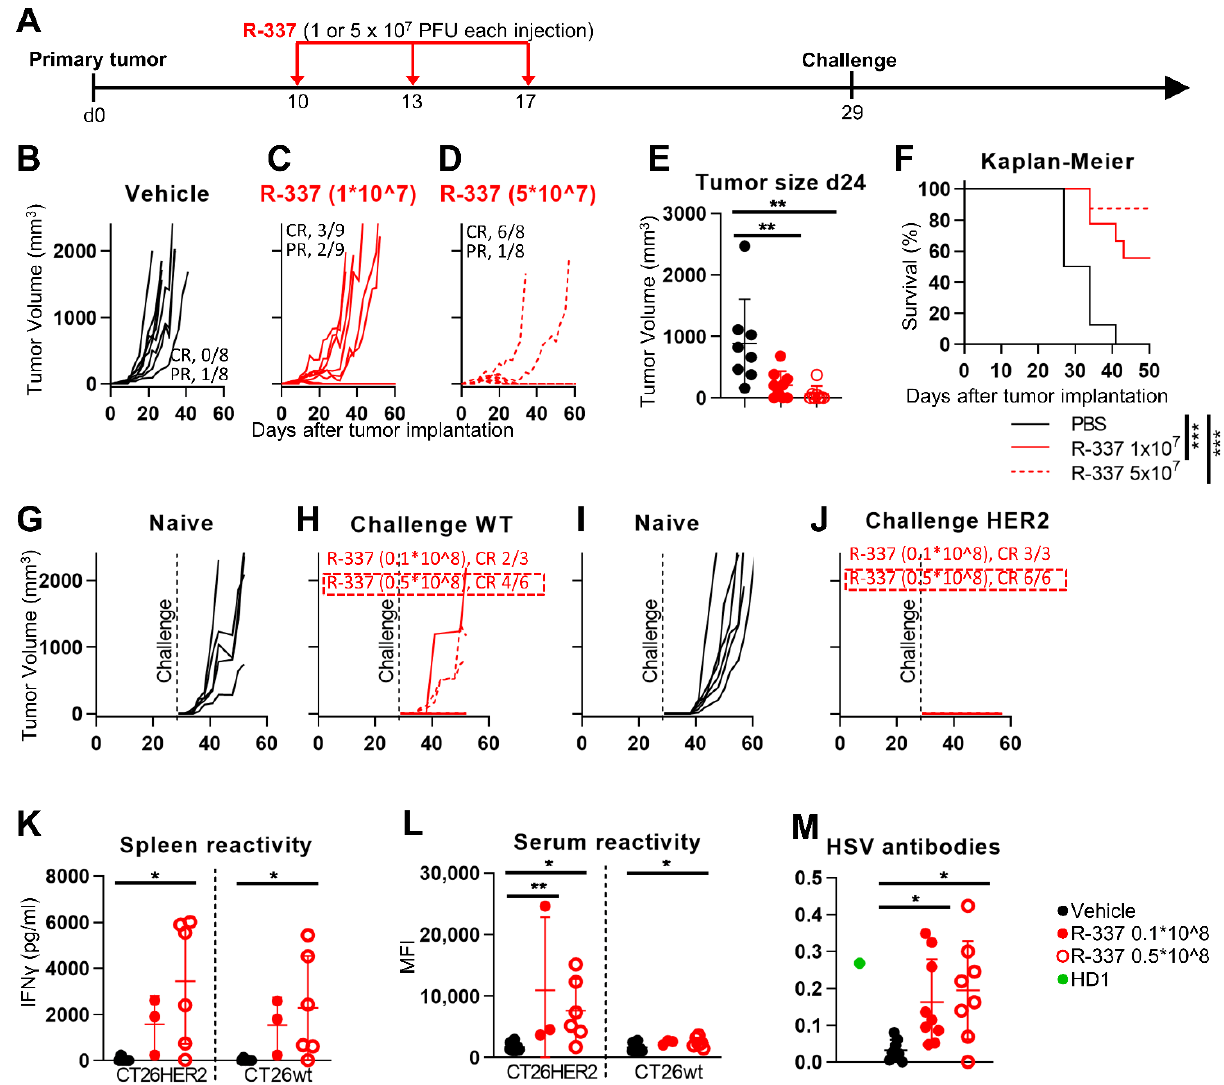
Figure 3. Efficacy of R-337 monotherapy on the growth of CT26-HER2 tumors. ( A ) Schedule of treatments. Six-to-eight week-old HER2-TG BALB/c mice were s.c. implanted in the left flank with 1 × 10 6 CT26-HER2 cells in 100 µ L of PBS. At d 10 after implantation, when the tumor volumes averaged 70 – 100 mm 3 , mice received 3 intratumoral injections of R-337, 1 × 10 7 PFU ( C ) (R-337 low), or 5 × 10 7 PFU (D) (R-337 high) per injection, diluted in 50 µ L PBS, or vehicle (50 µ L PBS), at intervals of 3–4 days. At d 29, the mice that survived the primary tumor received two contralateral challenge tumors made of CT26-wt and CT26-HER2 cells (1 × 10 6 each, per mouse), in the right and left flanks, respectively. ( B–D ) Kinetics of tumor growth in mice treated with vehicle ( B ), R-337 low (1 × 10 7 PFU) ( C ), or R-337 high (5 × 10 7 PFU) ( D ). The numbers reported in each panel indicate the numbers of mice that were completely cured from tumors (complete response, CR), or which showed a delay/reduction in tumor growth (partial response, PR). The mice were scored PR when the tumor volume was <50% smaller than the mean size of the tumors in the vehicle group. ( E ) Volumes of the primary tumors at d 24 after implantation. ( F ) Kaplan–Meier survival curves of the three groups of mice. ( G–J ) Kinetics of growth of challenge tumors in naïve mice ( G , I ), or in the R-337 survivors’ arm ( H , J ). Mice received simultaneously CT26-wt ( G , H ) and CT26-HER2 cells ( I , J ). ( K–M ) Immune response in splenocytes ( K ) and sera ( L , M ) harvested at sacrifice from naïve mice or from the R-337 low and R-337 high arms to CT26-HER2 or CT26-wt tumors cells or to HSV1-infected cells. ( K , L ) Details as in legend to Figure 1. ( M ) Antibody reactivity to HSV-1 in sera harvested at sacrifice from naïve mice or from the R-337 low and R-337 high arms. RS cells were infected with HSV-1 at 3 PFU/cell for 24 h, then they were fixed with paraformaldehyde,